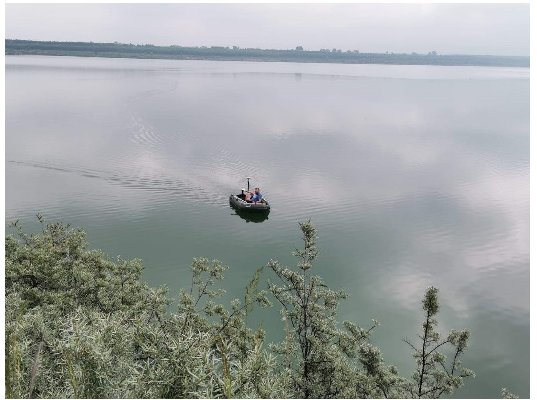
Figure 1. Measurement system installed on a pontoon.